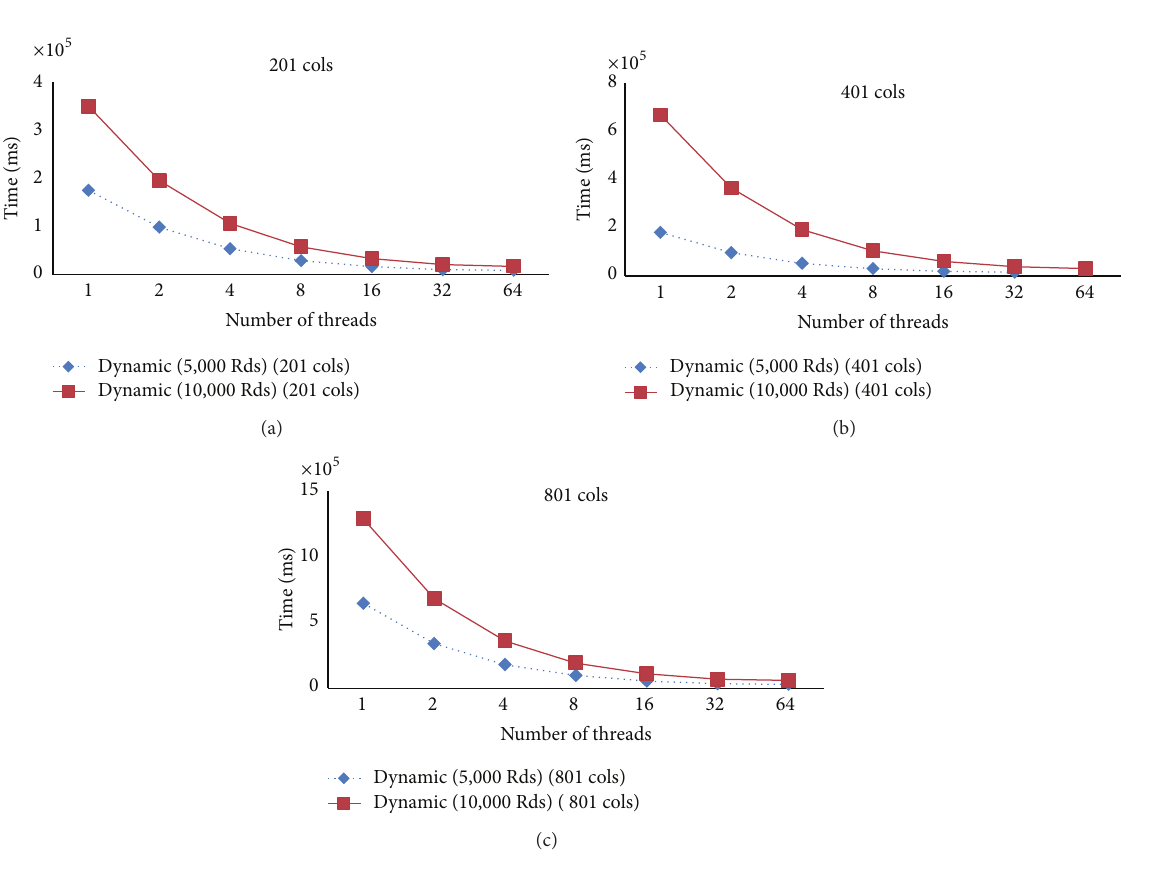
Figure 10: The computation time for the case numbers of columns, 201, 401, and 801, dynamic schedule varying number of iterations.